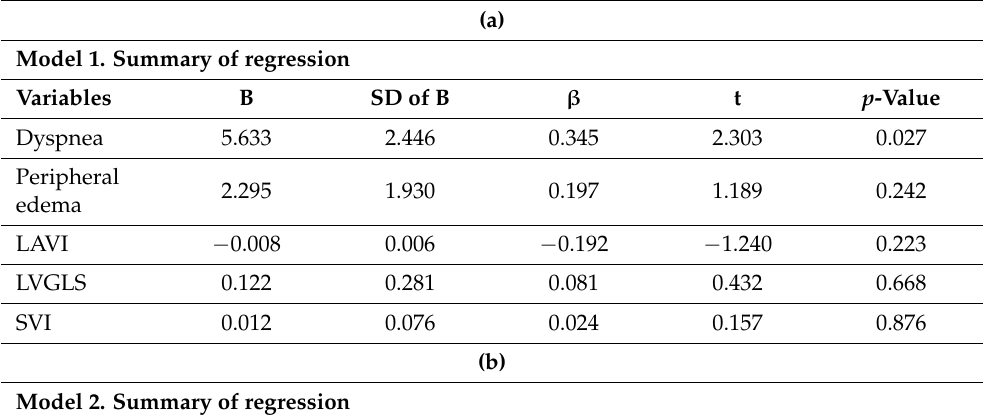
Table 4. (a). Multivariate linear regression analysis of the factors correlated with PHQ-9 scores in the overall patient group. (b) . Multivariate linear regression analysis of the factors correlated with MLHFQ scores in the overall patient group (n = 43).